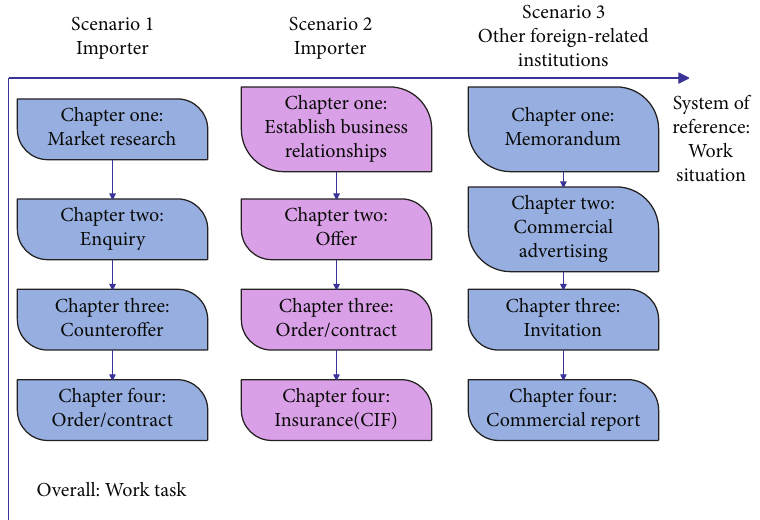
Figure 3: The content of business English writing teaching with systematic work